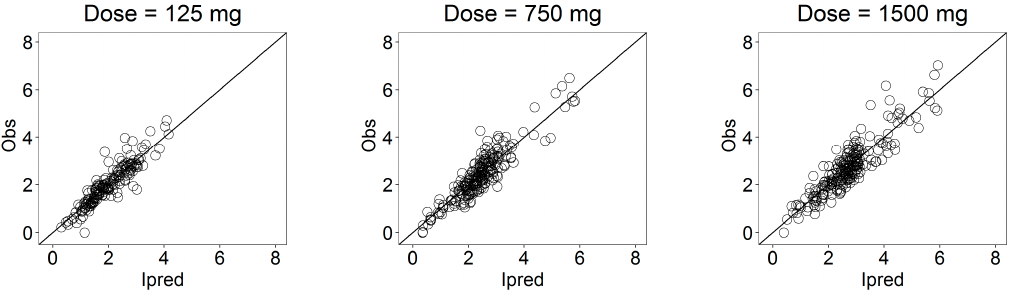
Figure A2. Goodness-of-fit plots for the serum concentration profile of progesterone stratified on the dose level.